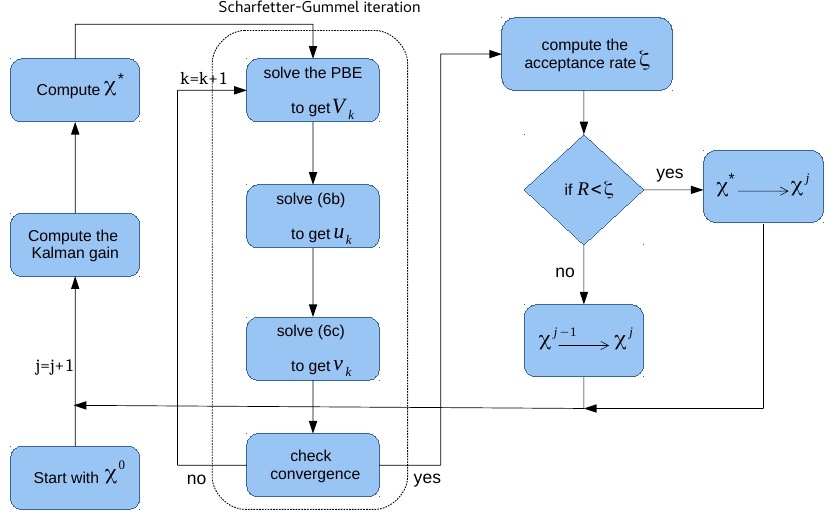
Figure 2. Bayesian inversion using EnKF-MCMC to identify the unknown material parameters, where the Scharfetter–Gummel iteration is used to solved the coupled system of